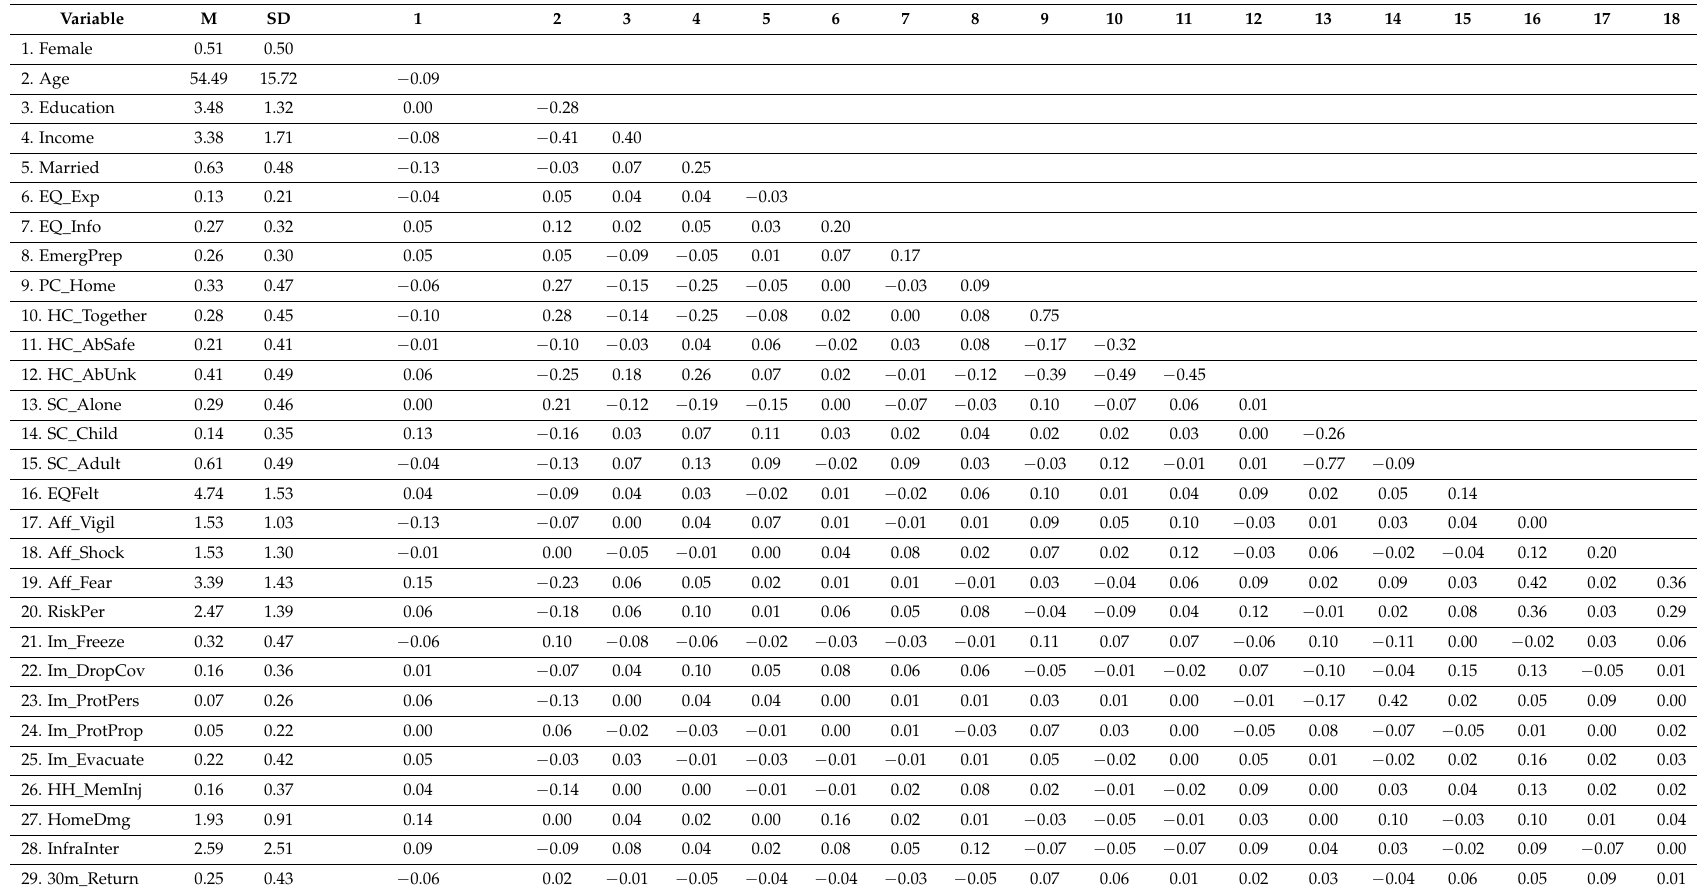
Table 2. Means (M), Standard deviations (SD), and intercorrelations among